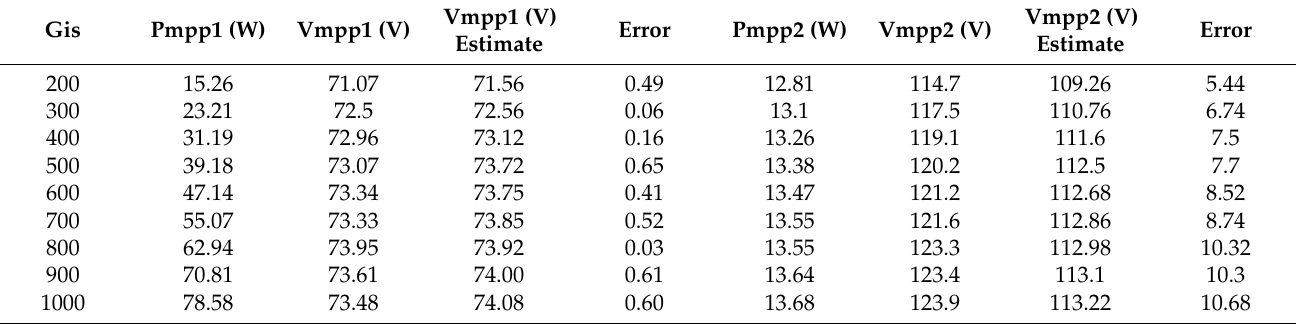
Table 4. The P-V characteristic data for test